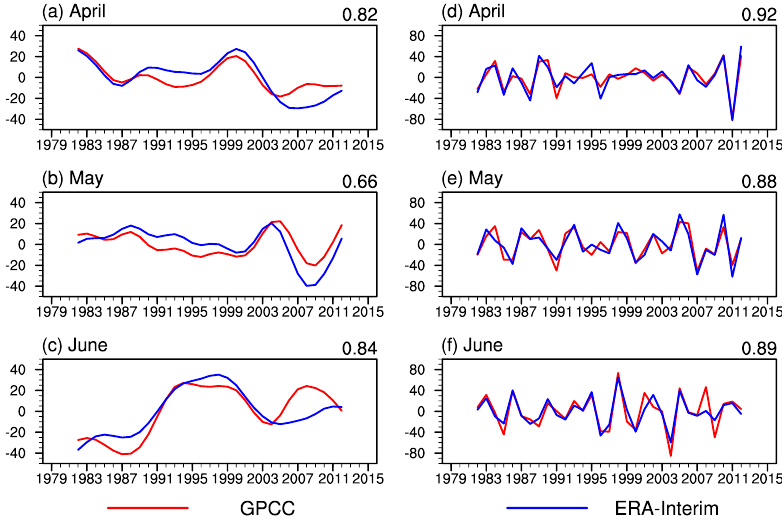
Figure 2. Time evolutions of area-averaged precipitation anomalies (units: mmmonth − 1 ) over South China for April, May and June during 1979–2015: ( a – c ) low-pass-filtered area-averaged precipitation anomalies for April, May and June based on GPCC (red lines) and ERA-Interim (blue lines); and ( d – f ) the same as ( a – c ) but for high-pass-filtered area-averaged precipitation anomalies. The correlation coefficients between the GPCC and ERA-Interim filtered area-averaged precipitation anomalies are given at the top right of each panel. Note that the area-averaged precipitation anomalies are obtained by removing the long-term mean of the area-averaged precipitation during all the corresponding calendar months of